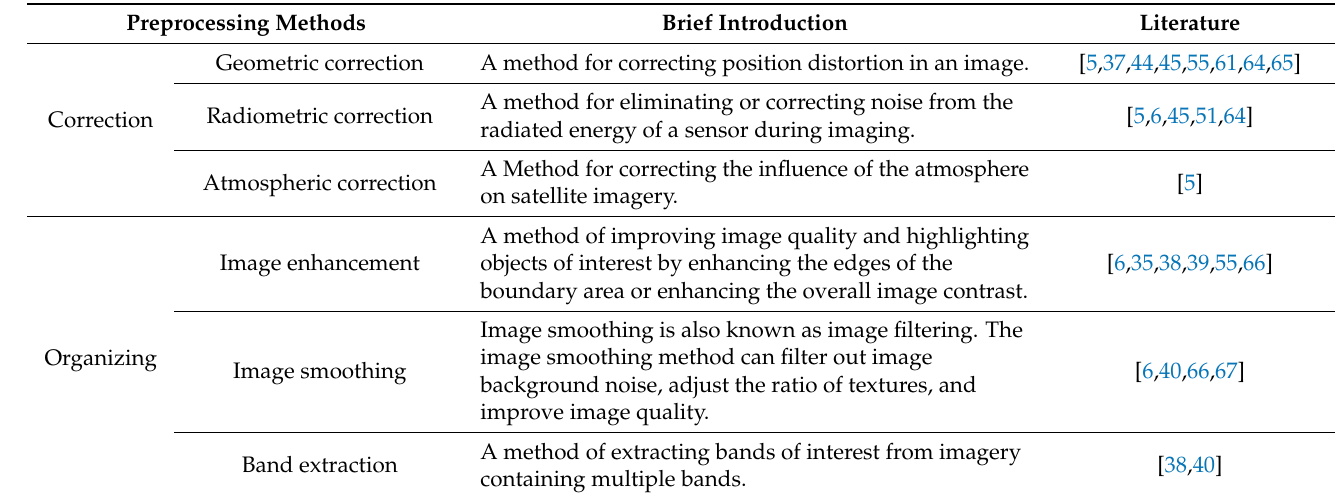
Table 3. Introduction to universal preprocessing